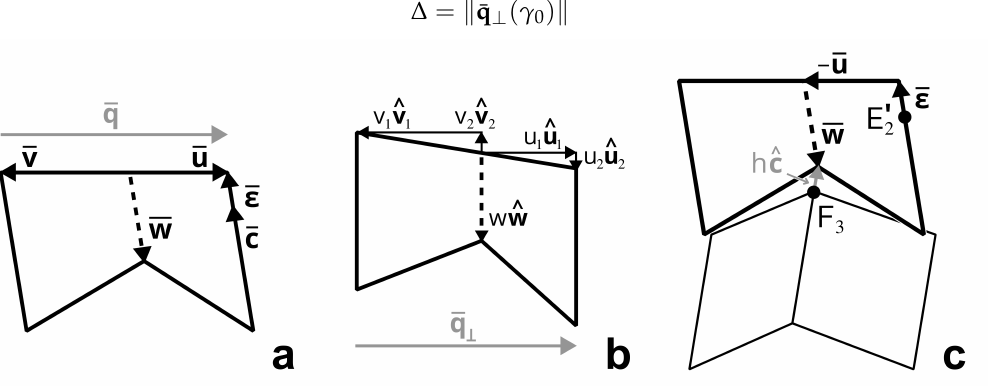
Figure 6. ( a ) Vectors in S 1 . ( b ) Vector components of ¯ u and ¯ v . ( c ) Relation between h and w in the ideal